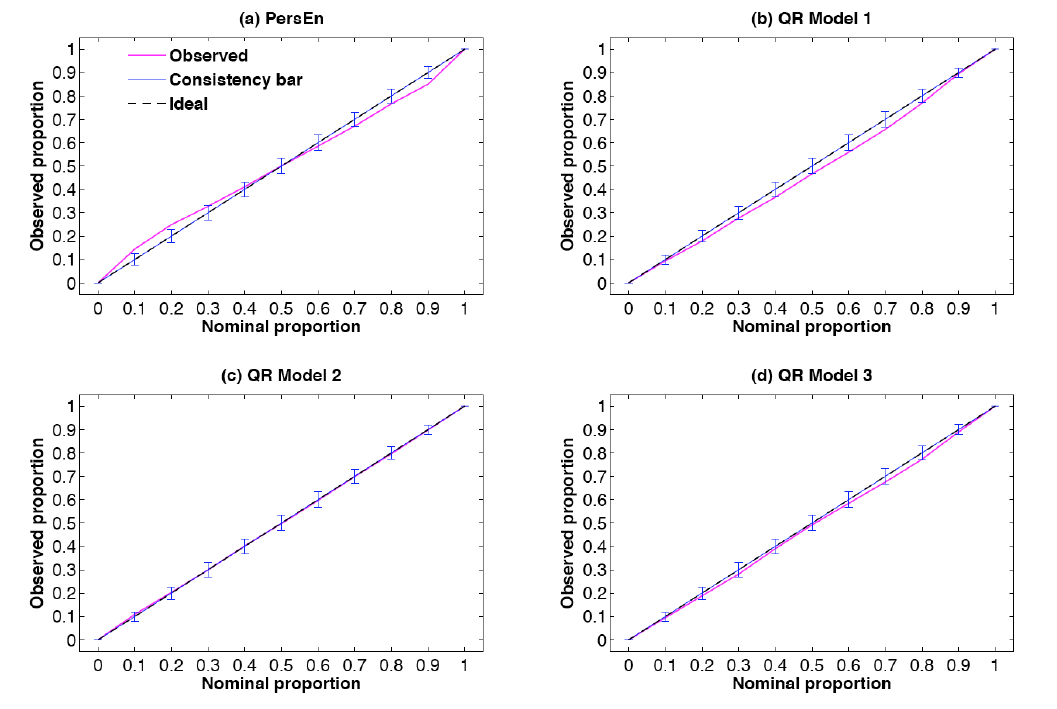
Figure 3. Reliability diagrams for the site of Le Tampon. ( a ) PersEns Model; ( b ) QR Model 1; ( c ) QR Model 2; ( d ) QR Model